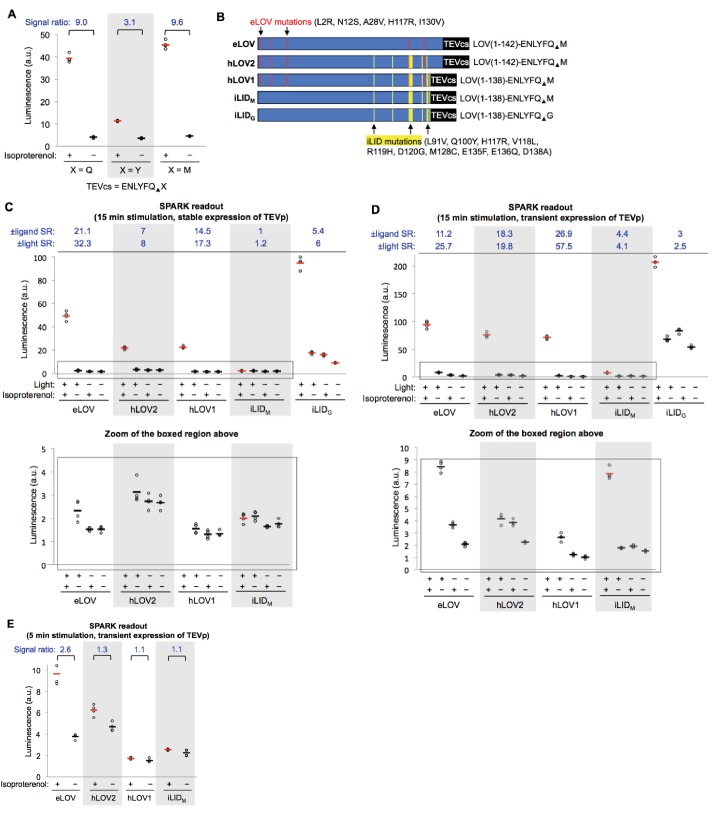
Characterization of SPARK – Testing alternative TEVcs sequences and alternative LOV domains.(A) Three alternative TEVcs sequences that differ at the P1´ site were tested in the context of β2AR-β-arrestin2 SPARK. HEK cells were prepared as in Figure 1D and stimulated with 10 μM isoproterenol and blue LED light for 5 min. Nine hours later, cells were analyzed for luciferase activity. Each condition was replicated four times. We then used the TEVcs sequence with X = M for all experiments in this study, except where indicated. (B) Five LOV-TEVcs fusions compared. eLOV (top) was engineered by directed evolution in a previous study122, and is used in all SPARK experiments in this study, except where indicated. The red lines indicate where the eLOV sequence differs from that of AsLOV2(G126A/N136E)122, the template used for directed evolution. iTANGO123 uses the LOV domain from iLID125 (bottom two constructs) and its TEVcs ‘bites back’ six amino acids into LOV’s Jα helix. Yellow lines indicate where iLID’s LOV sequence differs from that of AsLOV2(G126A/N136E)(Strickland et al., 2010). hLOV1 and hLOV2 are two hybrid LOV domains that merge the features of eLOV and iLID. TEVcs is the same in the top four constructs but has Gly instead of Met in the P1´ position in the bottom construct. (C) Comparison of five LOV-TEVcs fusions, with luciferase readout, and stable (low) expression of β-arrestin2-TEVp. The boxed region is enlarged underneath. HEK 293T cells were prepared as in Figure 1D, with β-arrestin2-TEVp stably expressed and SPARK β2AR-TF (containing one of five LOV-TEVcs sequences from (B)) and UAS-luciferase transiently expressed. 18 hr post-transfection, cells were stimulated with 15 min of isoproterenol and ambient light. Nine hours later, cells were analyzed for luciferase activity. Each condition was replicated four times. ± Ligand signal ratios (SR) and ±light signal ratios for each construct quantified across top. (D) Same as (C), but with transient overexpression of β-arrestin2-TEVp component, instead of stable/low expression. The boxed region is enlarged underneath. (E) Same as (D) but with 5 min instead of 15 min light stimulation.